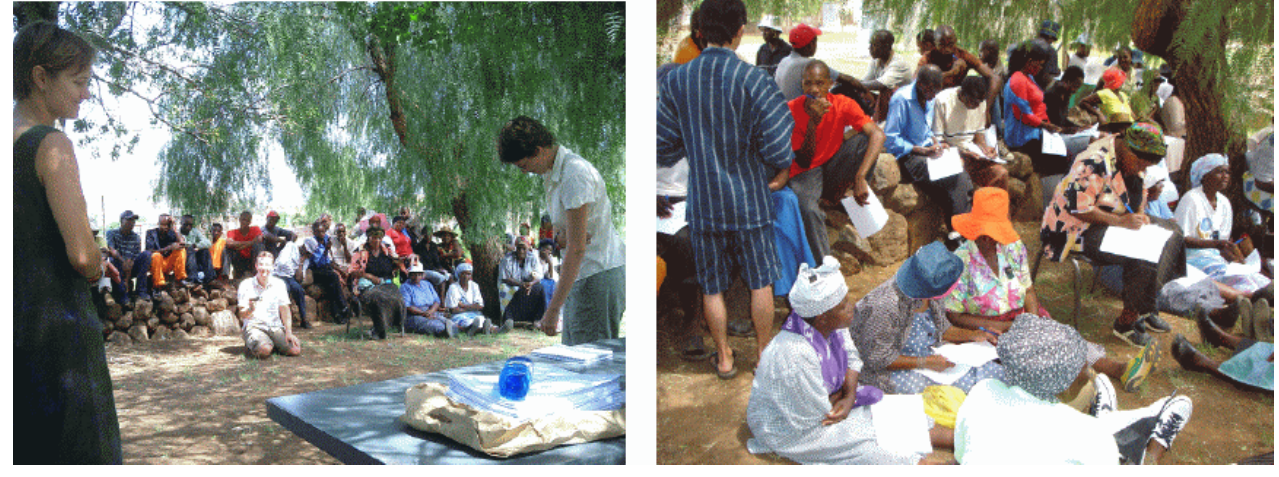
Fig. 1. Short play describing possible stress scenarios (left) and participants filling in the stated preference questionnaire